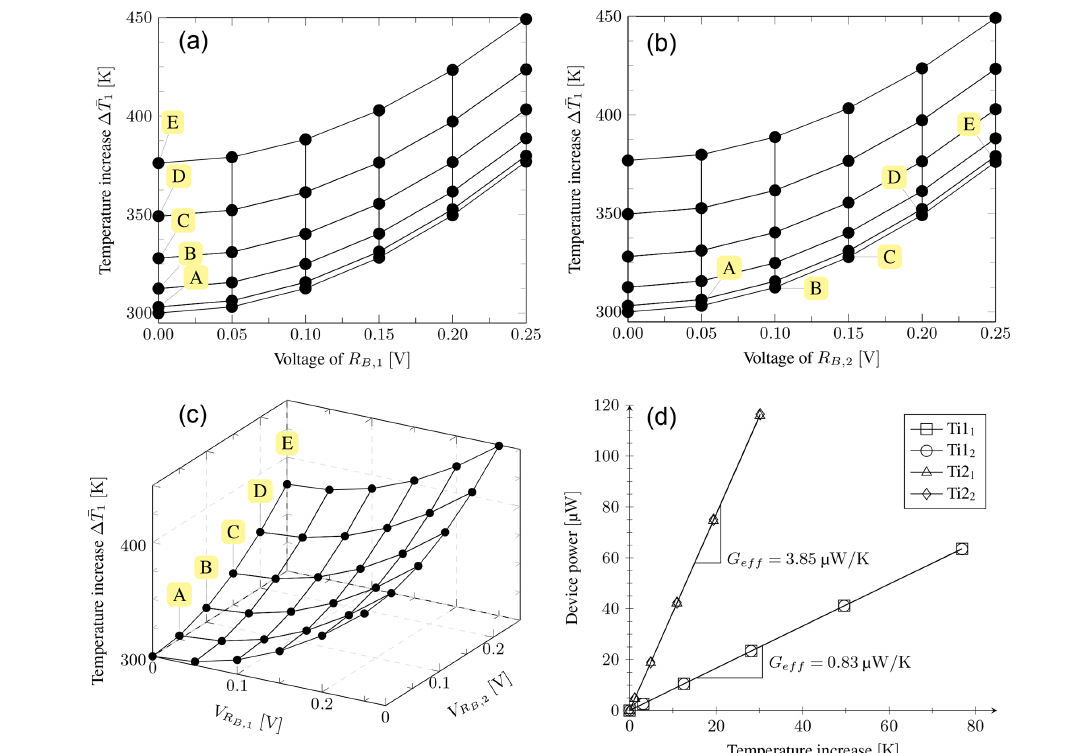
Figure 6. Simulation results of the thermoelectric interaction that exists for the Ti devices under vacuum conditions. (a) XZ projection of the thermal profile of R B 1 for Ti1. (b) YZ projection of the thermal profile of R B 1 for Ti1. (c) 3-D thermal profile of R B 1 for Ti1. (d) Temperature curves at different power levels to extract the beam thermal conductance.